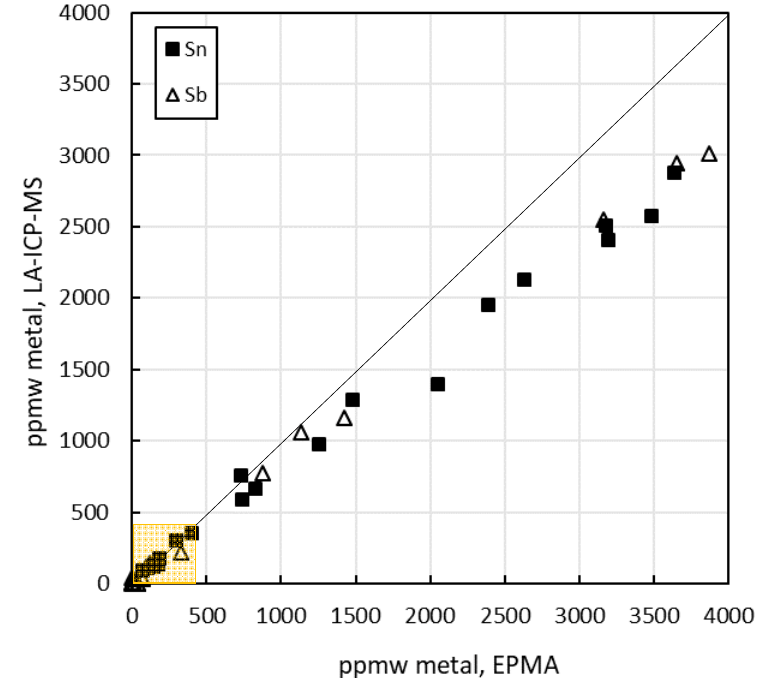
Figure 9. Concentrations of tin and antimony in slags, analyzed with EPMA and LA-ICP-MS techniques. For concentrations inside the orange square, LA-ICP-MS results were used. EPMA results were utilized for the higher concentrations.